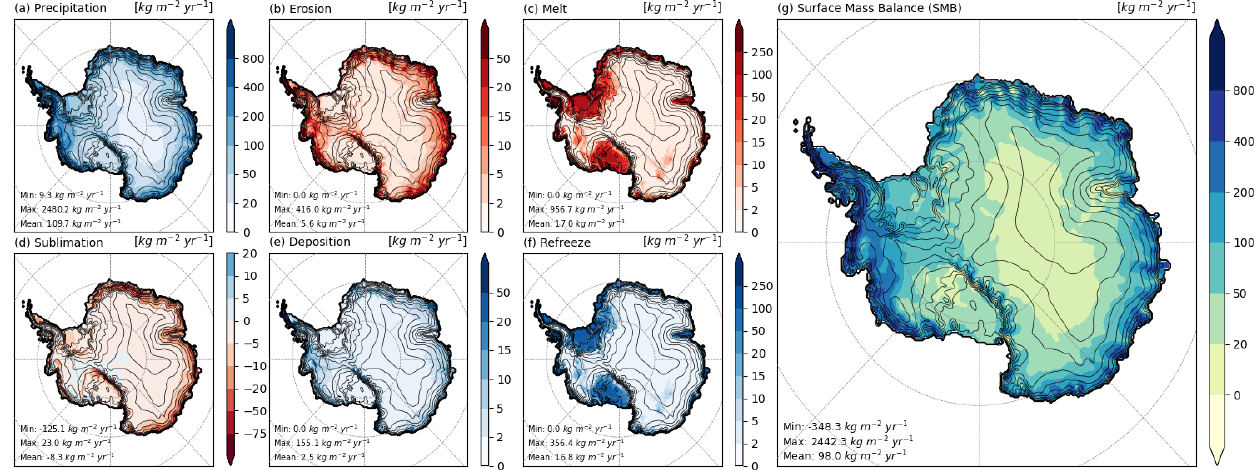
Figure 7. Components of the surface mass balance output directly from